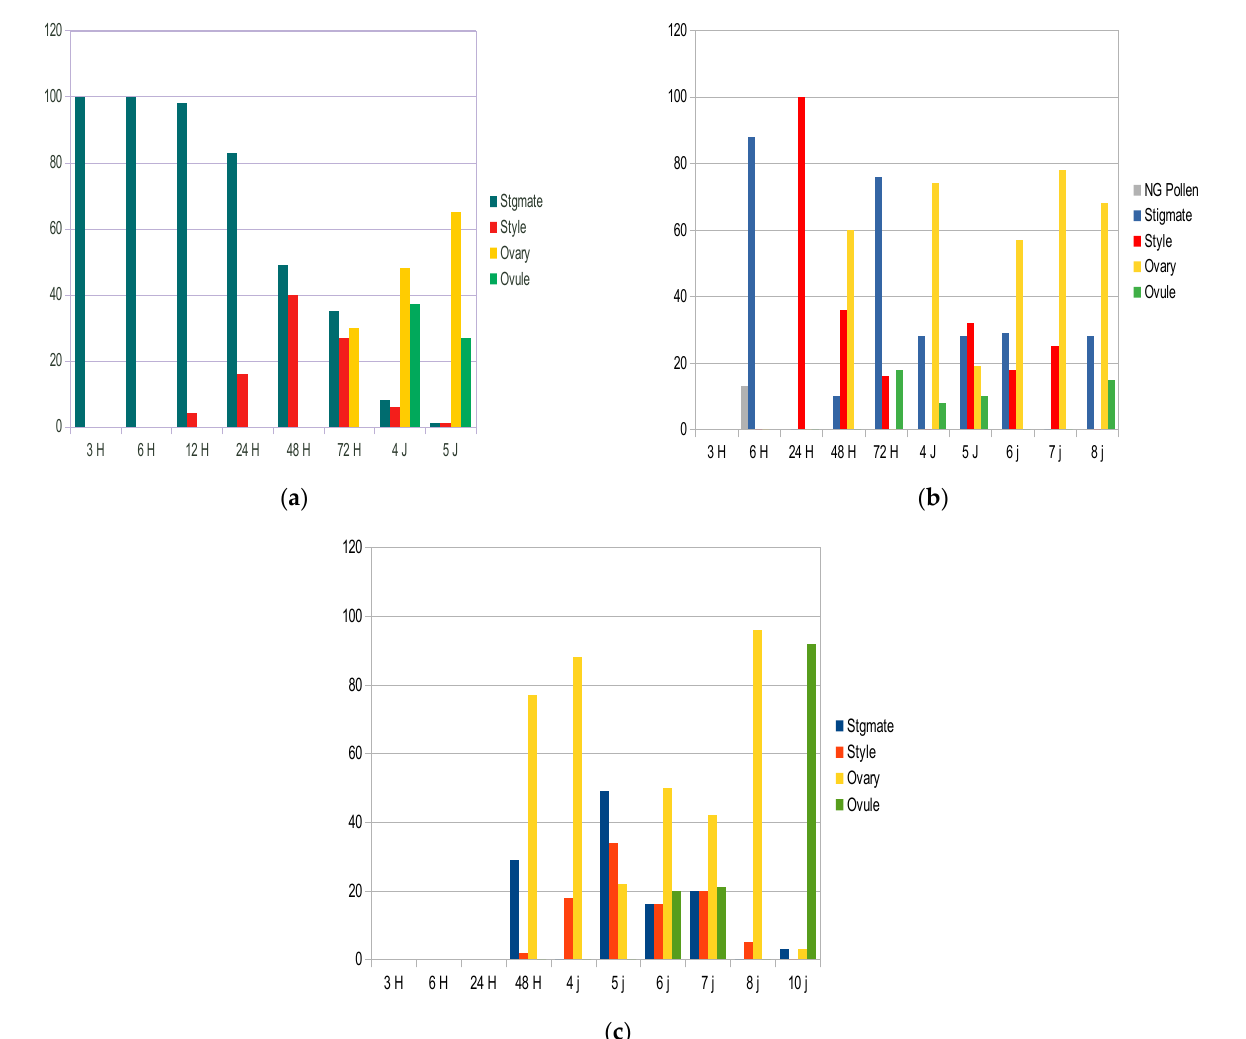
Figure 1. Histogram showing progression of pollen tubes over 10 days in ( a ) Olivière × Arbequina ; ( b ) Olivière × Chemlal ; ( c ) Chemlal × Arbequina . Redrawn from Ouksili [18].